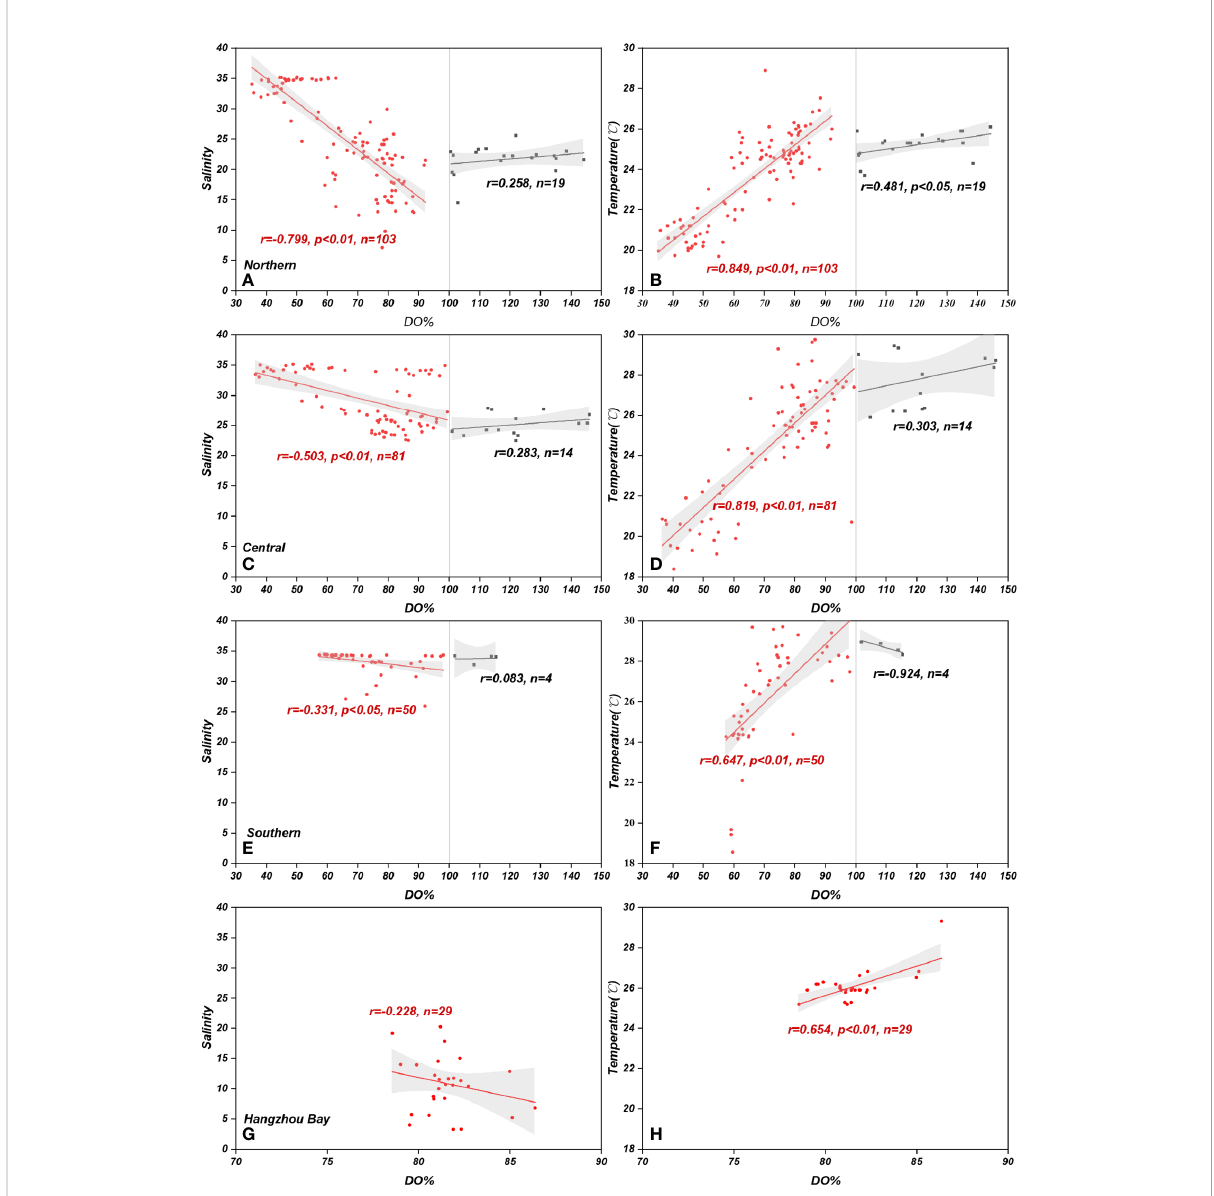
FIGURE 7 Correlation analysis. Correlation analysis between DO saturation and salinity (A, C, E, G) . Correlation analysis between DO saturation and temperature (B, D, F, H)